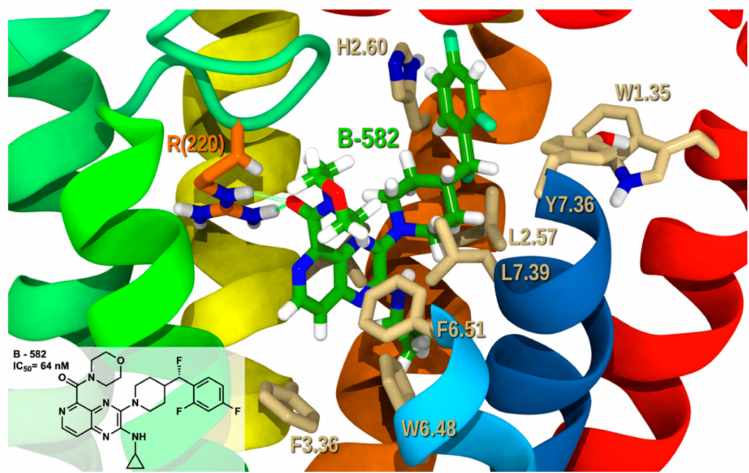
Figure 8. B-582 / GPR6 R complex. The view from the lipid bilayer with the EC portions of TMH6-7 removed for clarity.